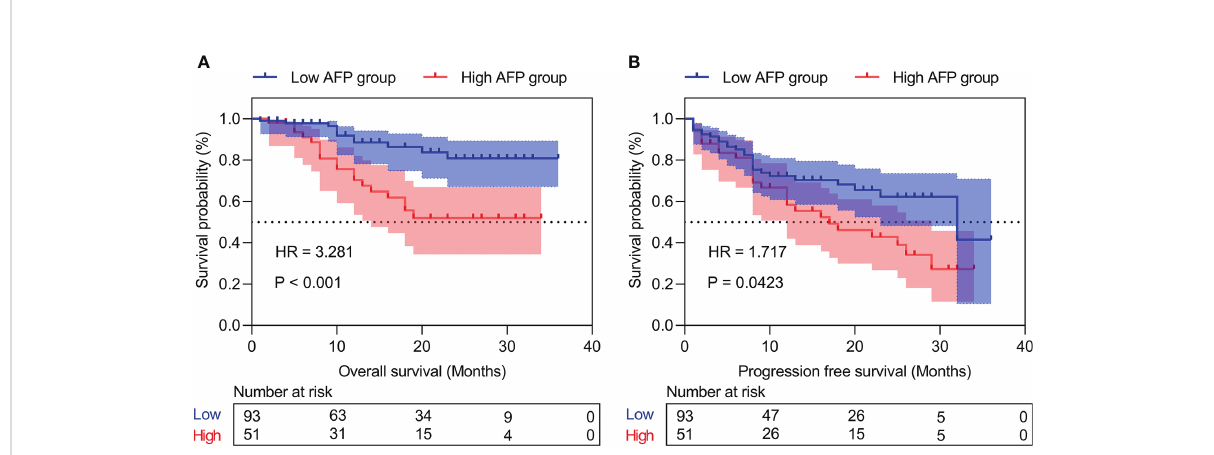
FIGURE 3 Kaplan ‐ Meier curves of the different AFP levels for overall survival (A) and progression-free survival (B) . AFP, alpha-fetoprotein.